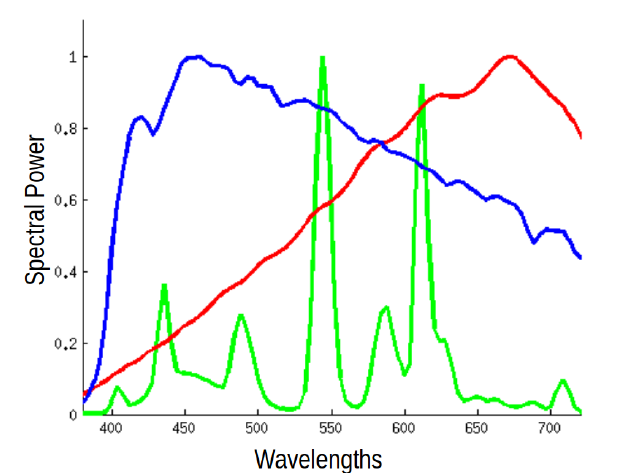
Figure 8. Spectral sensitivities of the three illuminants used in Experiment 1b.